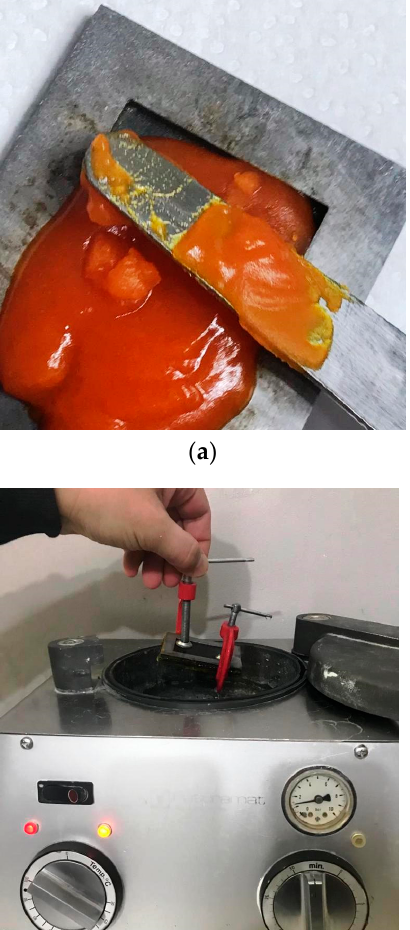
Table 1. Specifications of acrylic resin-based materials used in this study.